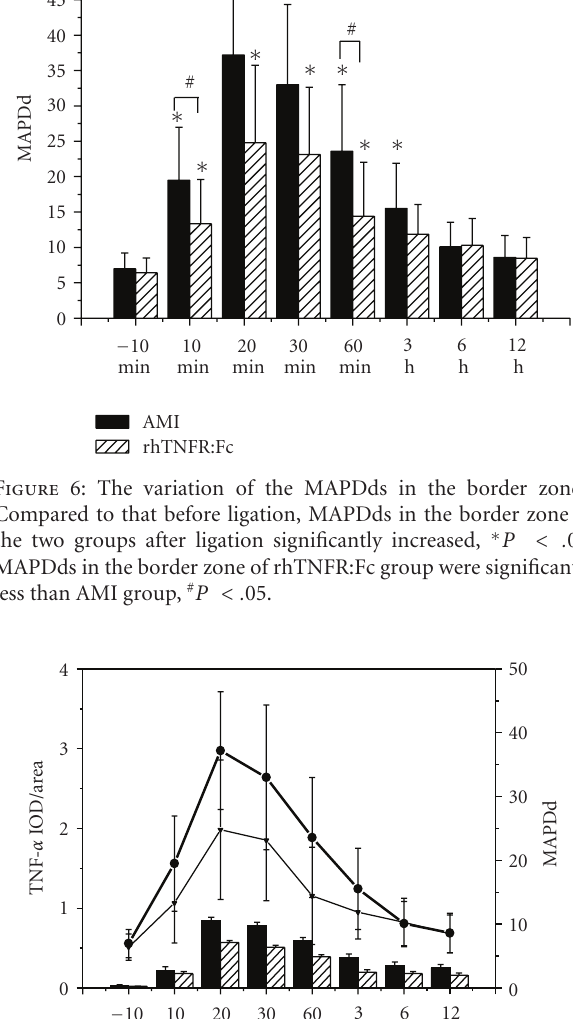
Figure 5: The correlation between TNF- α expression and VFs.